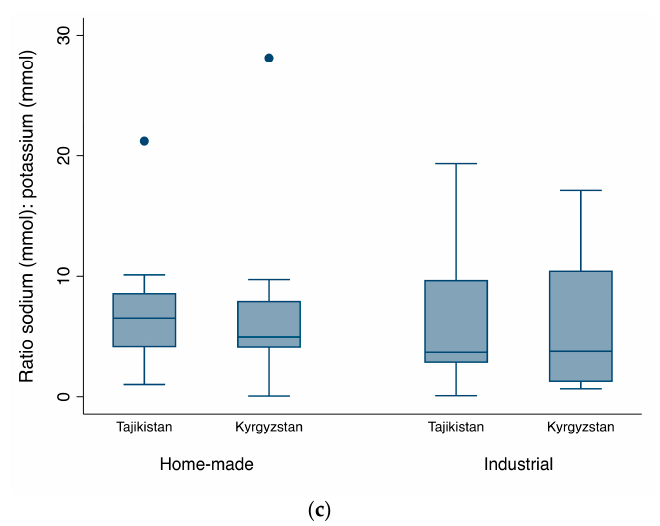
Figure 2. Per-serving average of ( a ) sodium; ( b ) potassium content; and ( c ) molar sodium:potassium